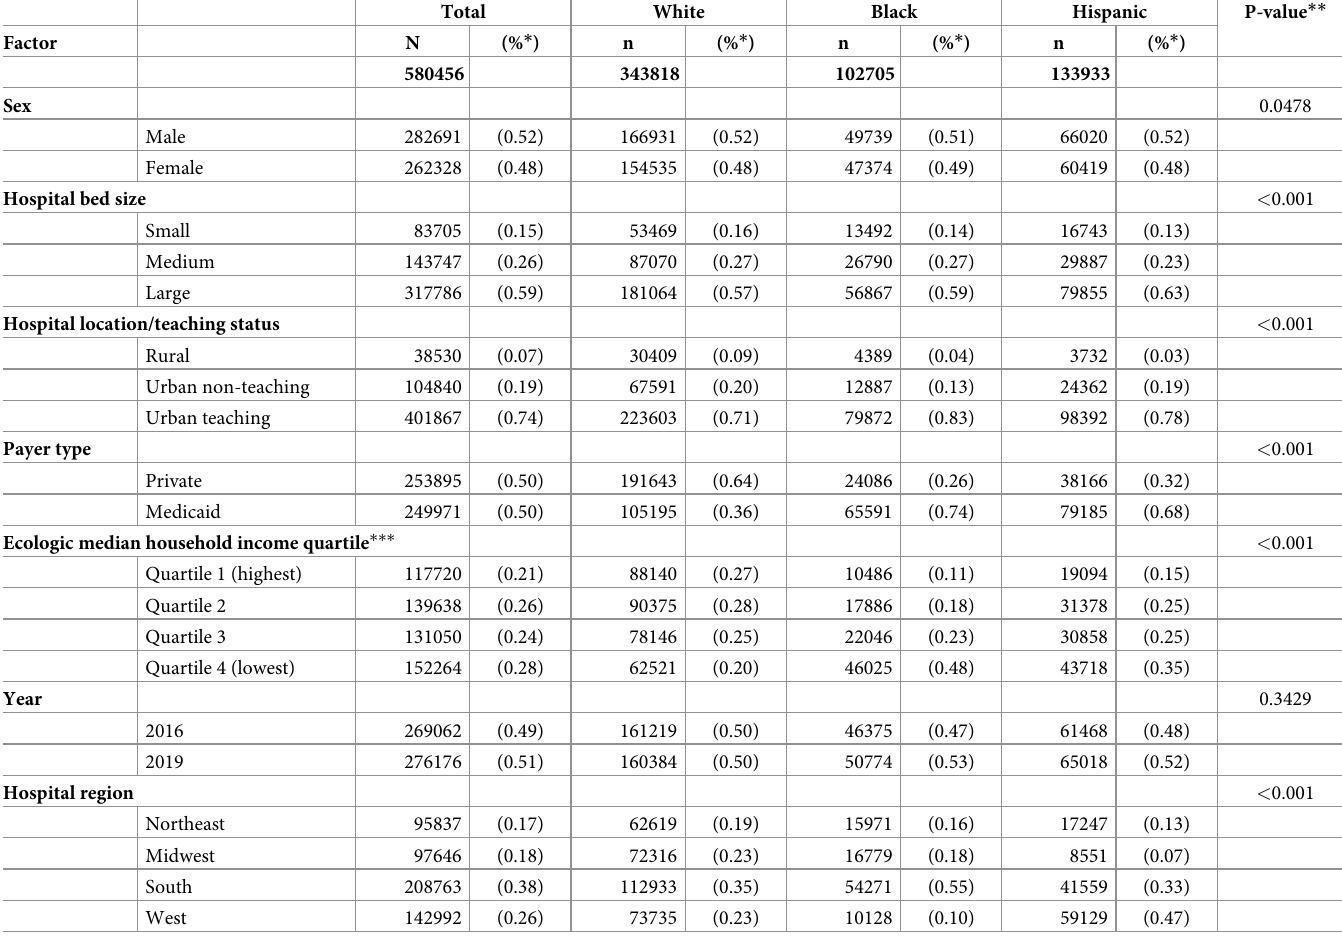
Table 1. Distribution of select population characteristics by